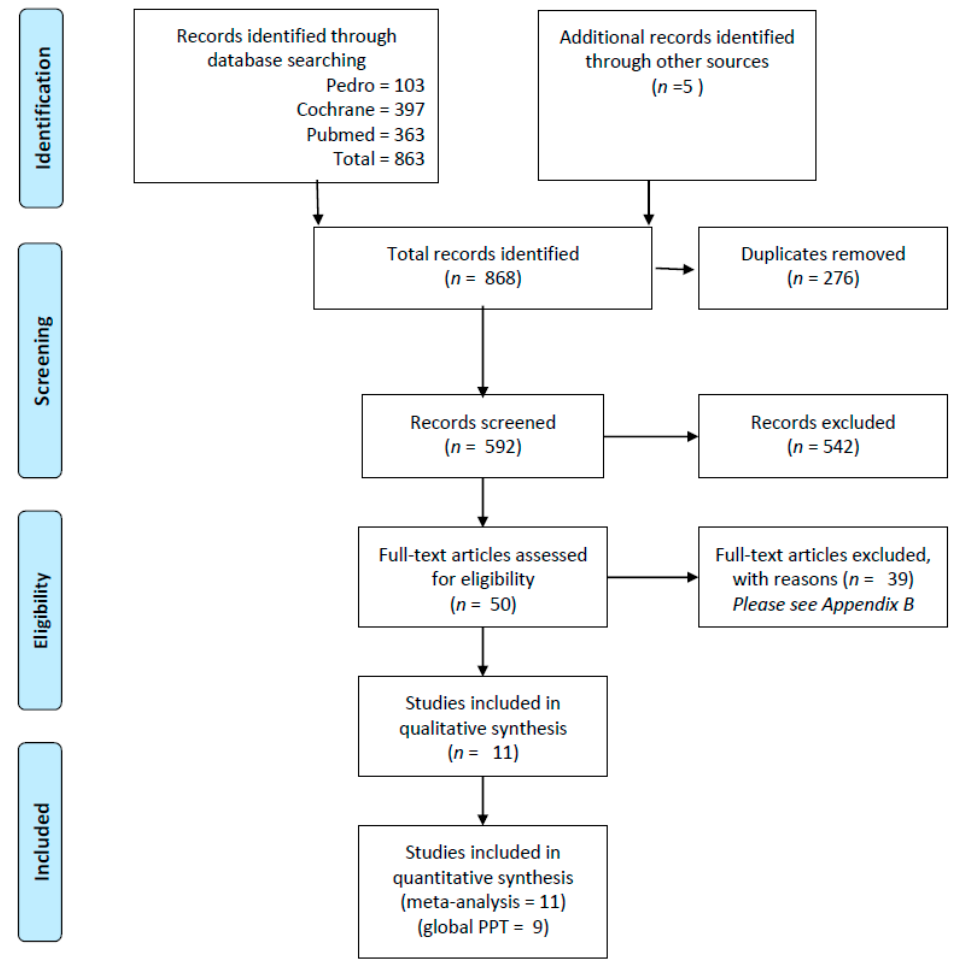
Figure 1. PRISMA flowchart of the systematic literature review [42].